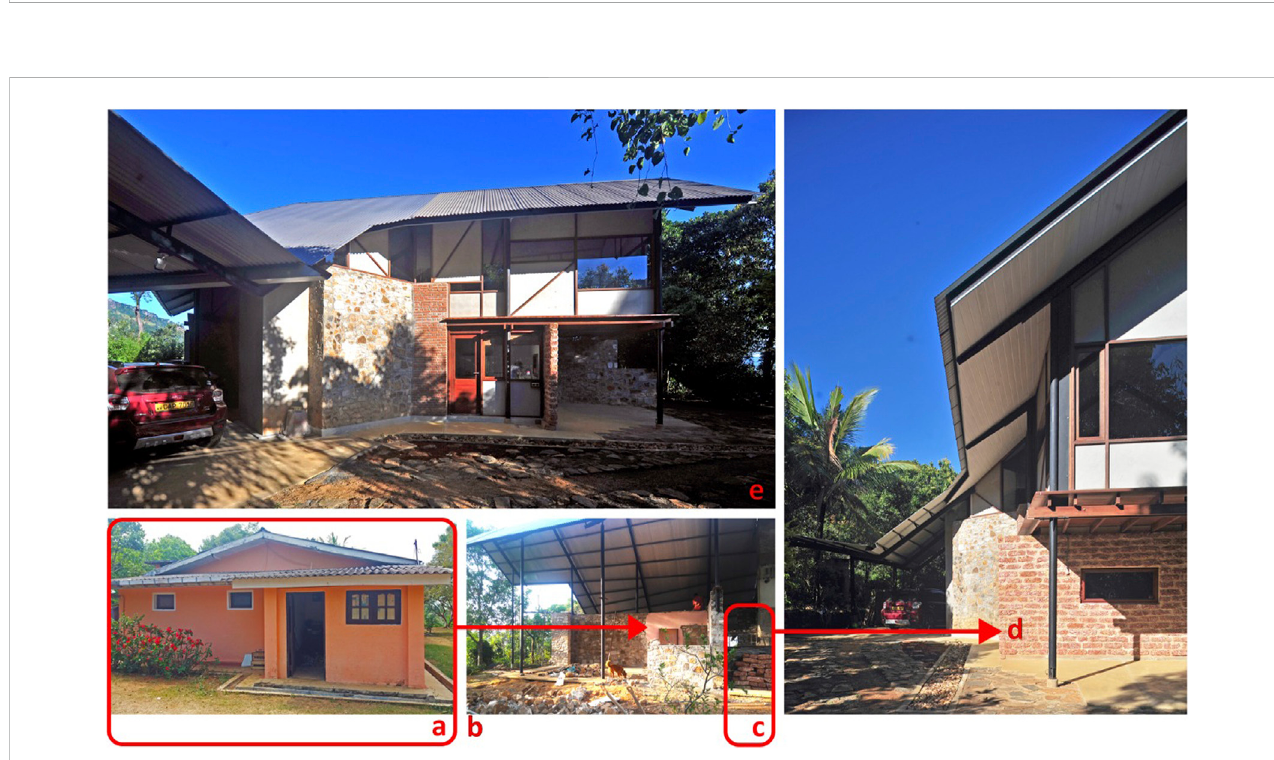
FIGURE 10 Mountain house. (A) The old house on site; (B) the new structure and roof ‘ sheltering ’ the retained fabric; (C) kabok bricks ‘ found ’ on site; (D) the new, reused kabok brick wall de fi ning the entrance to the house; (E) the bricolage-like formal language accommodates a seemingly-random mix of new and ‘ found ’ material: stone, clay bricks, kabok bricks, timber, lath and plaster, steel structural skeleton, metal roo fi ng,